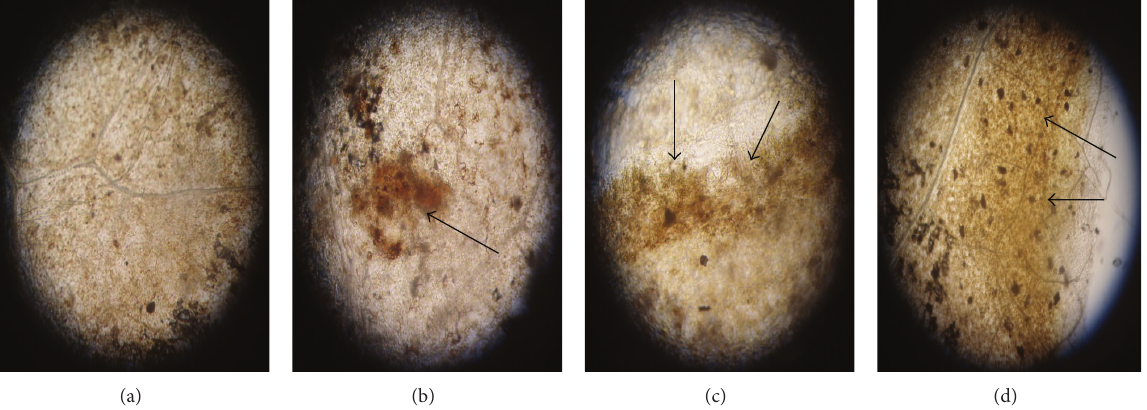
Figure3:H 2 O 2 detectionintomatoleavesbyDABstain,24 hafterCuCl 2 treatment.(a)Control;(b)treatmentwith1mMCuCl 2 ;(c)treatment with 2.5 mM CuCl 2 ; and (d) treatment with 5mM CuCl 2